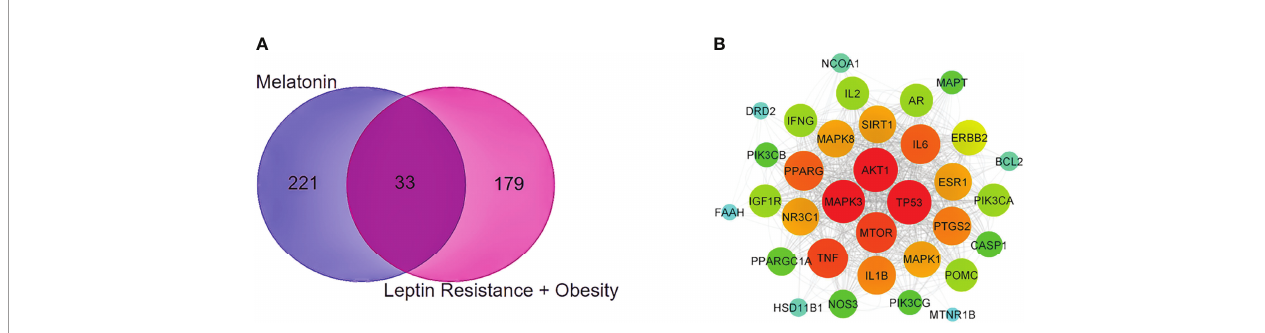
FIGURE 4 | PPI network and Venn diagram of melatonin remedial targets in LR induced obesity. (A) The common targets of melatonin and LR induced obesity are depicted in the Venn diagram intersection. (B) PPI network of common remedial targets. The node sizes from large to small and color from red to cyan indicate the degree values in